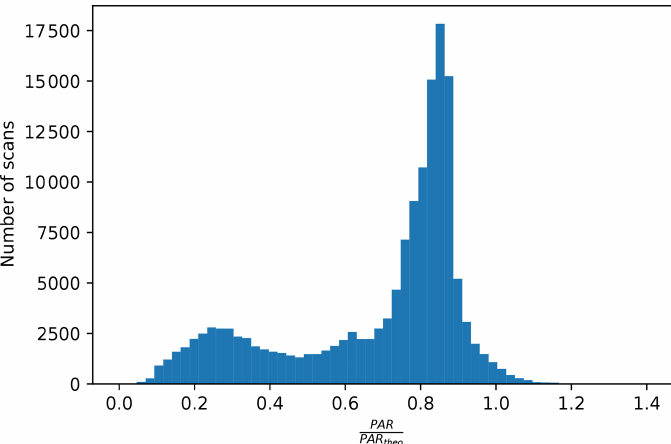
Figure B1. The distribution of the ratio of the measured PAR to the PAR at theoretical maximum from all individual scans.